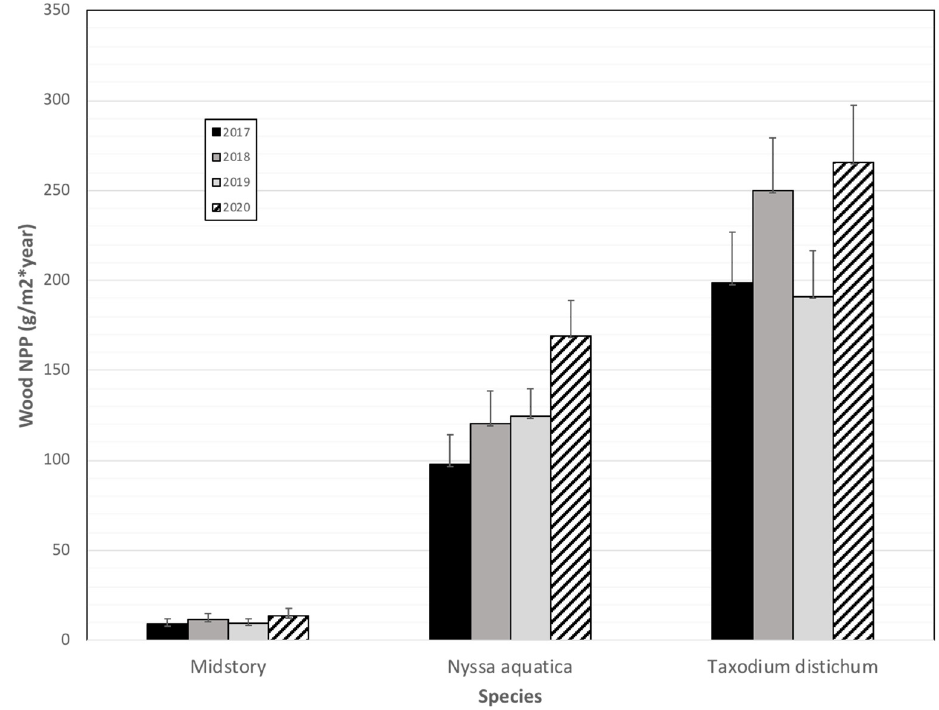
Figure 8. Net primary wood production (gm m − 2 y − 1 + s.e.) for midstory species, Nyssa aquatica , and Taxodium distichum for 2017 (black), 2018 (dark gray), 2019 (light gray), and 2020 (striped) growing seasons. Midstory species were nearly all Acer rubrum var. drummondii .